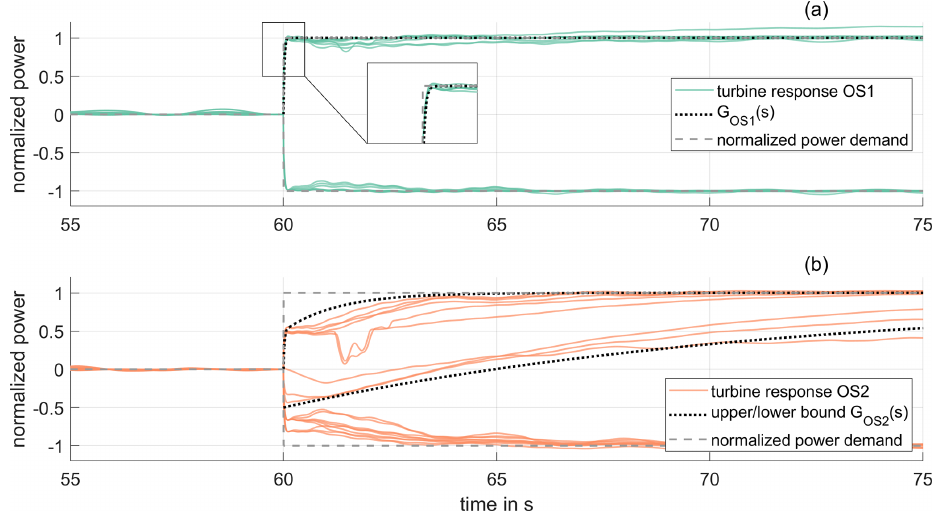
Figure 6. Normalized step response for demand steps of (cid:49)p d = {− 0 . 3 , − 0 . 2 , − 0 . 1 , 0 . 1 , 0 . 2 , 0 . 3 } when operating the turbine at a power reserve with p d = 0 . 7 in constant wind for (a) OS1 and (b) OS2. Comparison of the step response to the synthetic transfer functions G OS1 ( s ) and G OS2 ( s ) designed for control design and simulation studies on a power system or wind farm